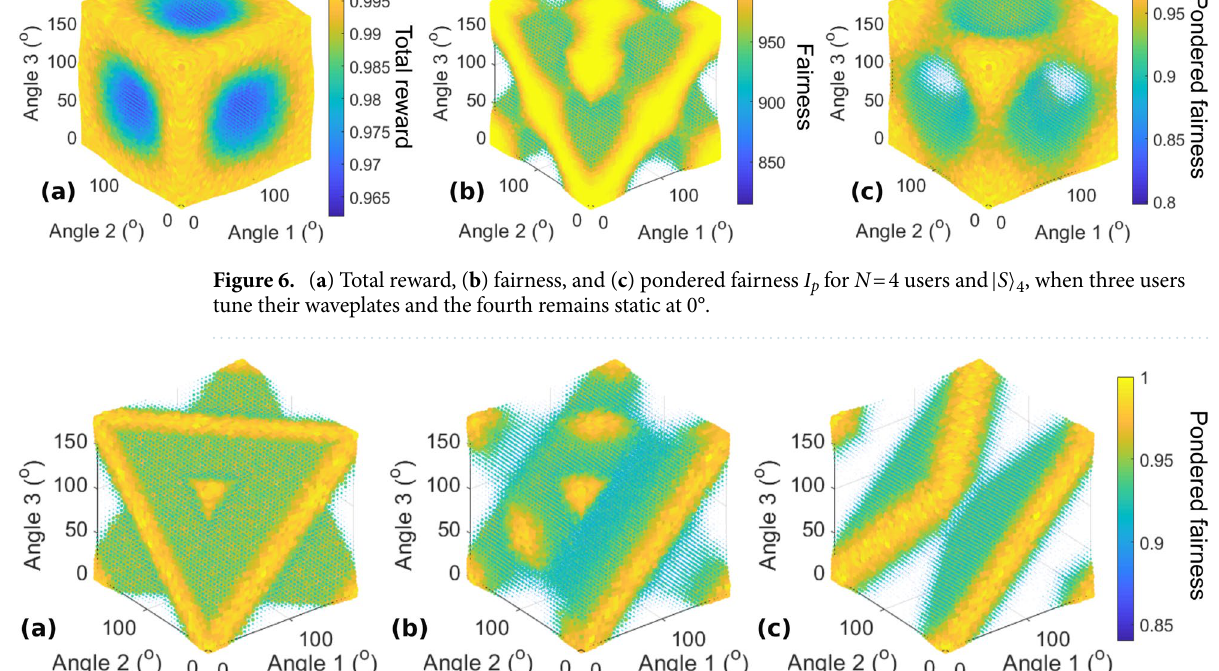
4 users and A 4 (φ) for different values of φ , when three users tune their | � =